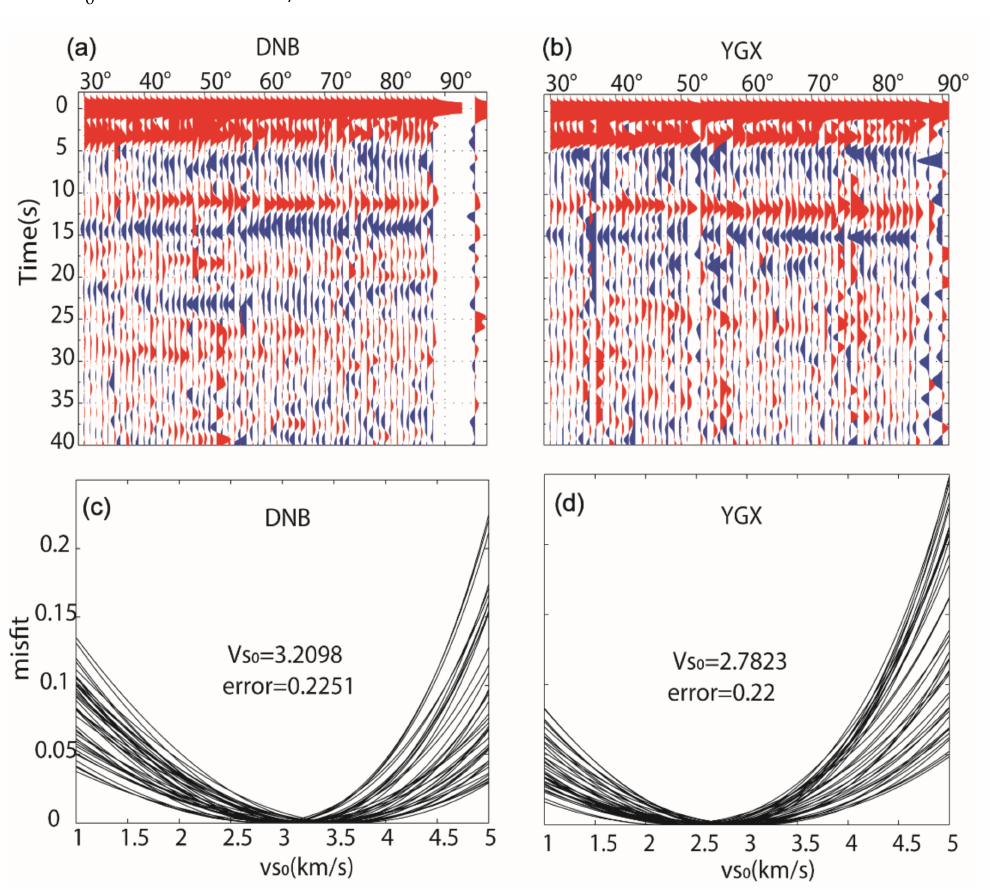
Figure 4. Receiver functions of the DNB and YGX stations ( a , b ) as well as their subsurface SWVs ( c , d ). Receiver functions of different epicentral distances to the DNB and YGX stations (alpha = 1.5). The thin line indicates the Vs 0 search process, while the “+” symbol represents the optimal Vs 0 to be searched in the